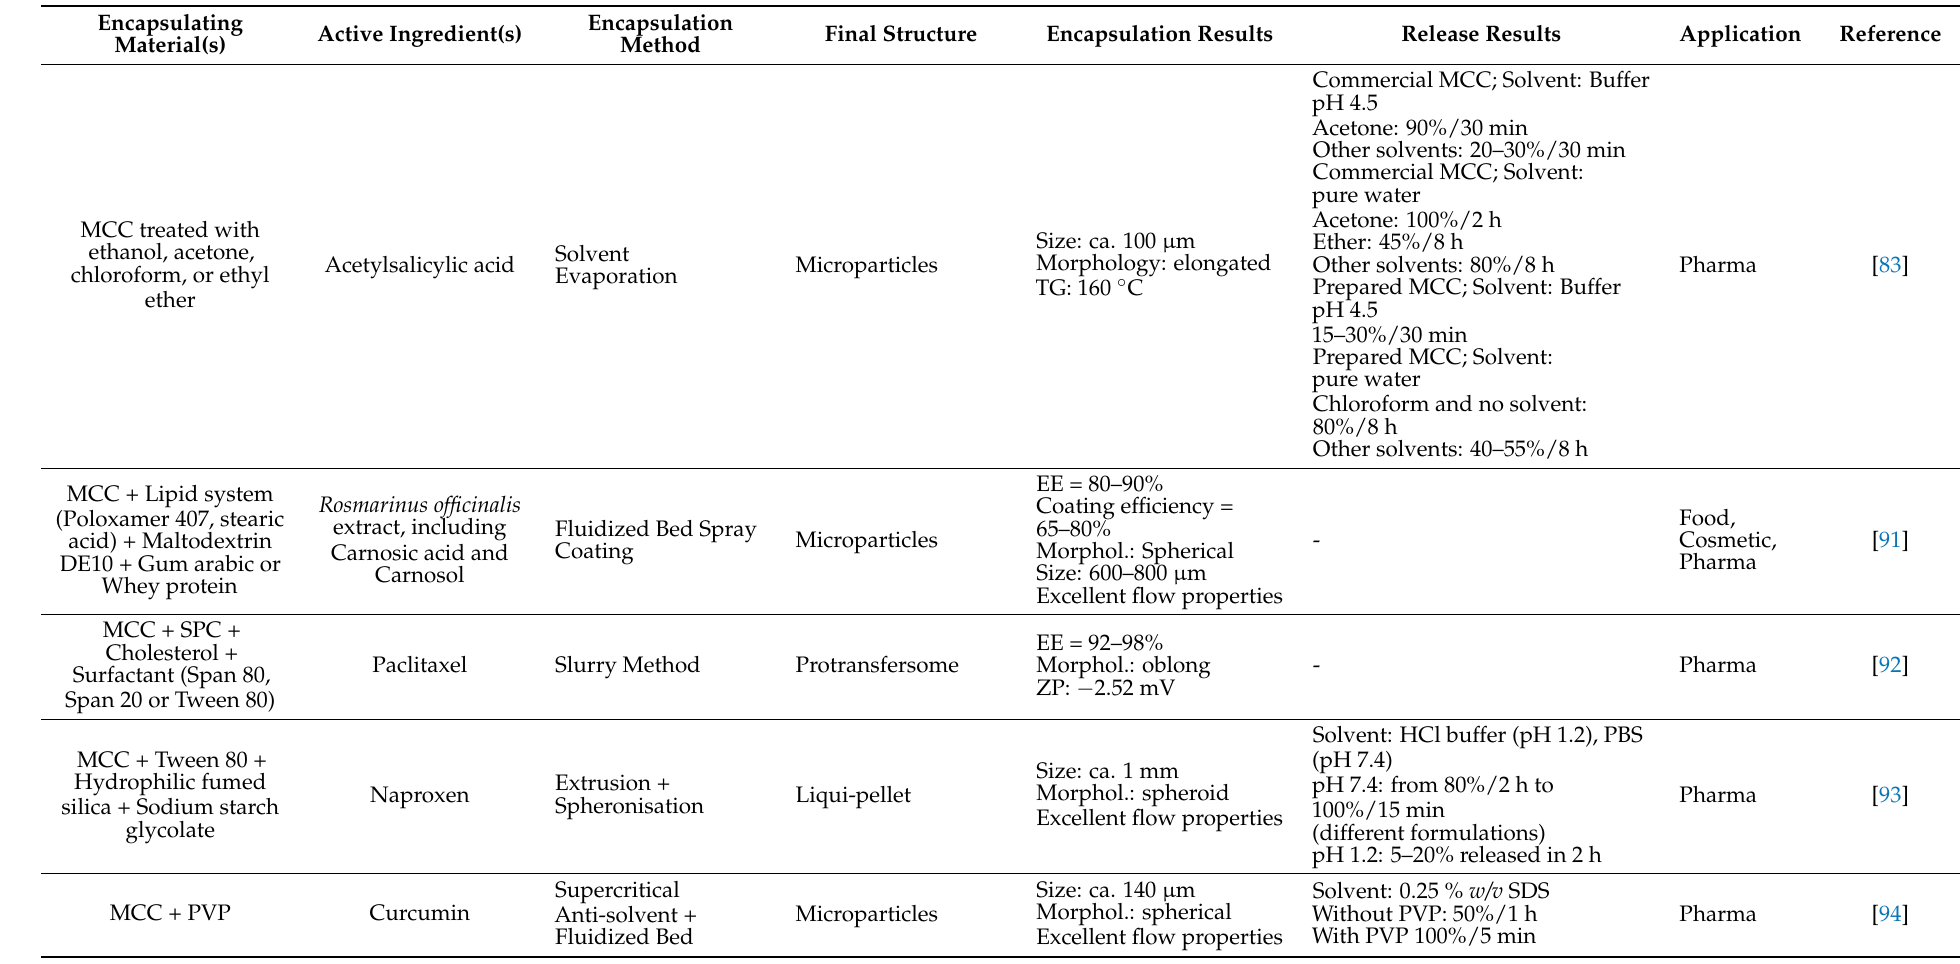
Table 2. Studies on the use of microcrystalline cellulose for the encapsulation and release of liposoluble